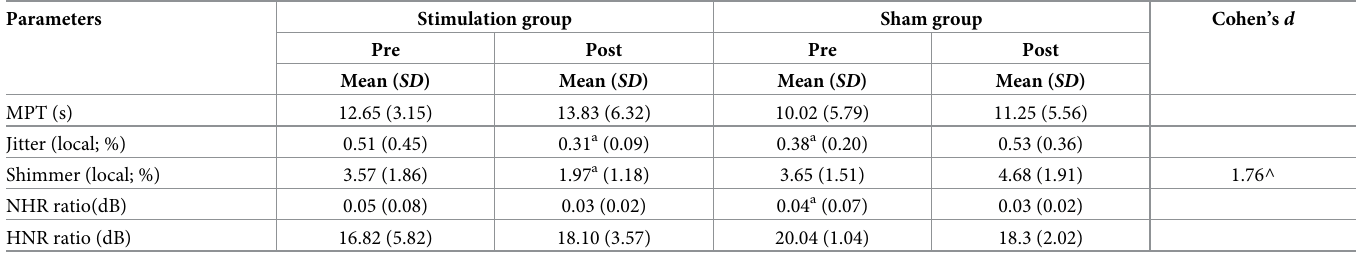
Table 4. Mean (and standard deviation) maximum phonation time and other voice-related measures for the stimulation and sham groups before and after treatment.